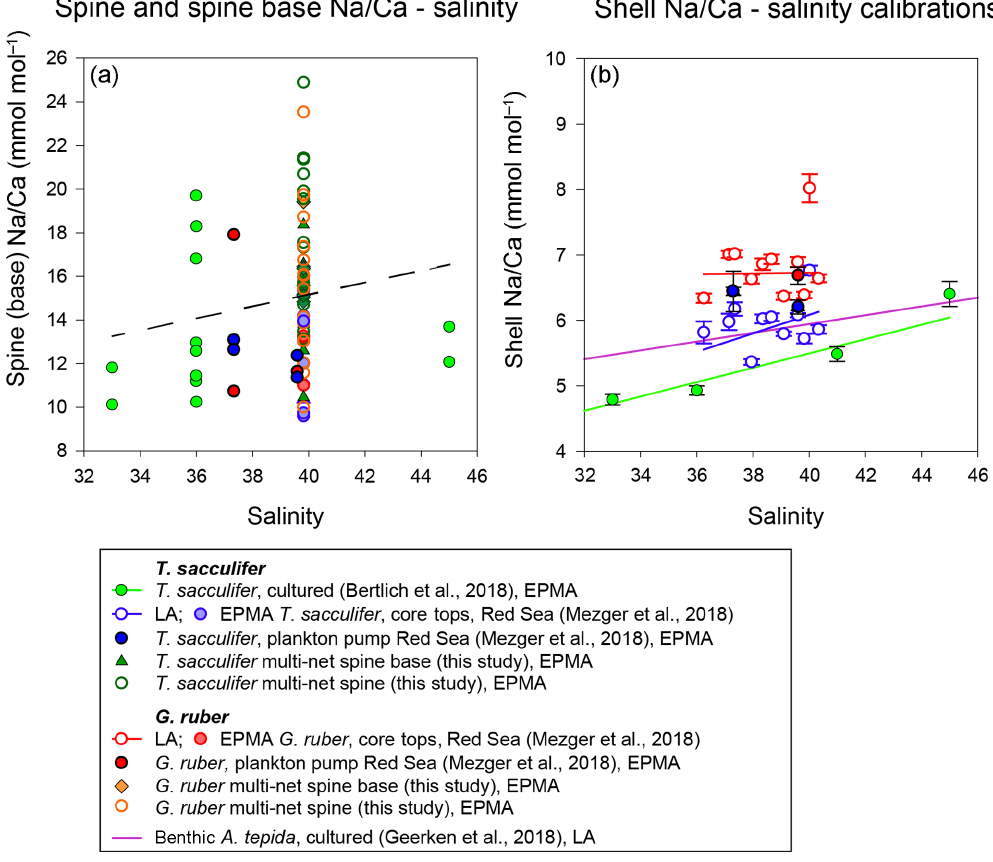
Figure 10. (a) Changes of Na / Ca spine bases and spines (multi-net only) with salinity, with the trend of all data indicated with the dashed line and (b) comparison of different existing Na / Ca shell–salinity calibrations with indicated standard errors. The regression lines refer to the samples in the same color (also indicated in the legend). We have also separated data based on the analytical technique used, which were EPMA and laser ablation (LA) measurements,